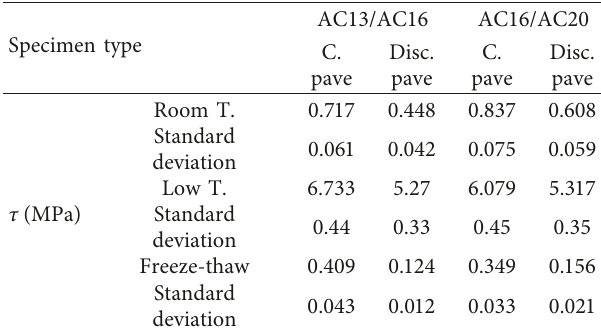
Figure 12: Comparison of test results from modes of specimen damage. (a) Continuous paving. (b) Discontinuous paving. Table 11: Summary of direct shear test results.